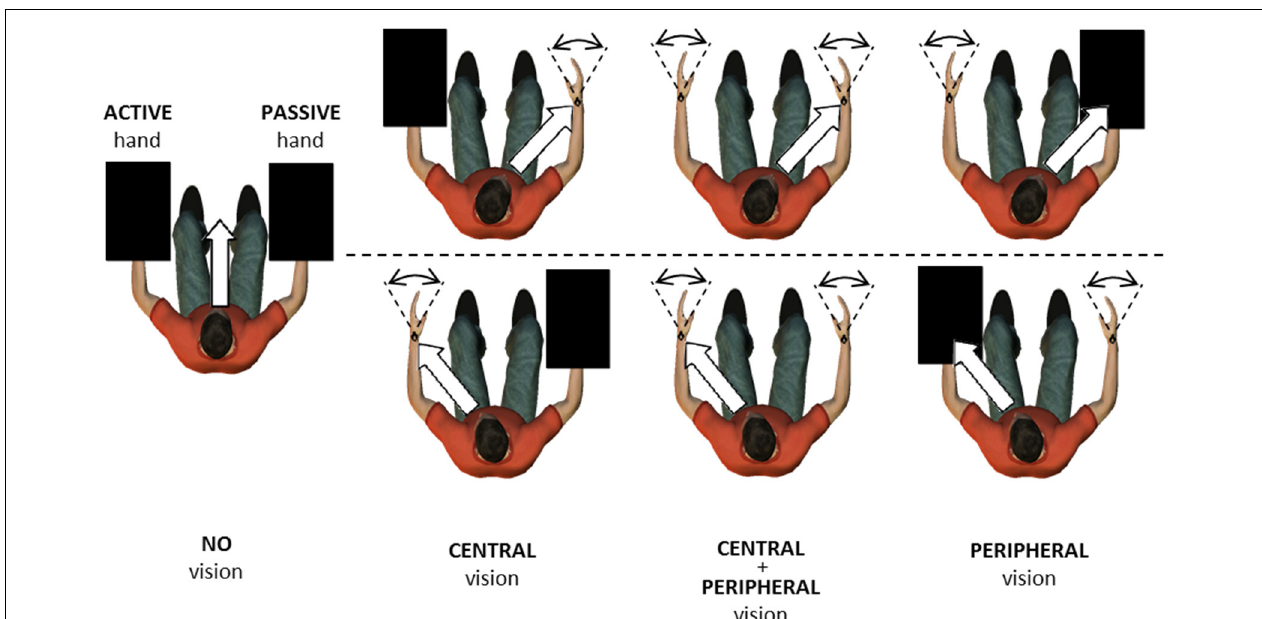
FIGURE 2 | Top view of the experimental setup in No vision, Central vision, Central + Peripheral vision, and Peripheral vision conditions. In all conditions, participants were instructed to match a motor-driven right-hand movement (passive) with their left hand (active). Wrist movements ranged